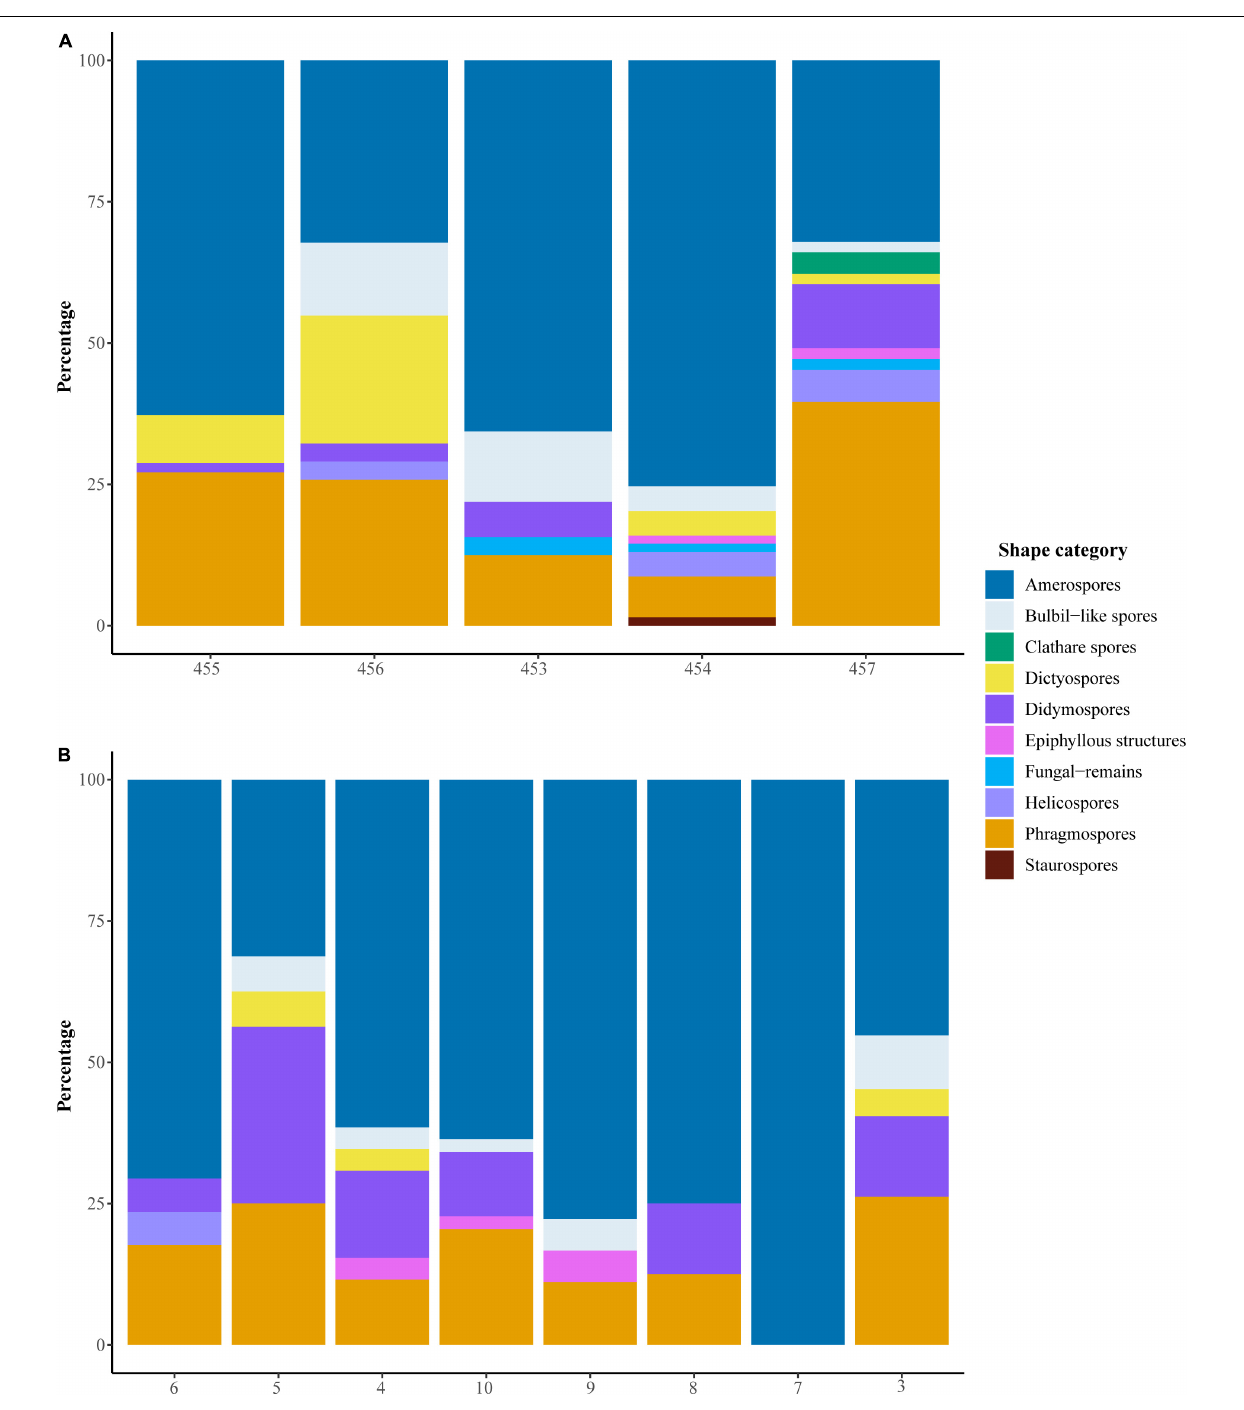
morphological variation with spores from eight morphological groups ( Figure 7A ). In this sample, amerospores represented 75% of the variation, while the other morphologies accounted for the remainder ( Figure 7A ). Some of the spores identified